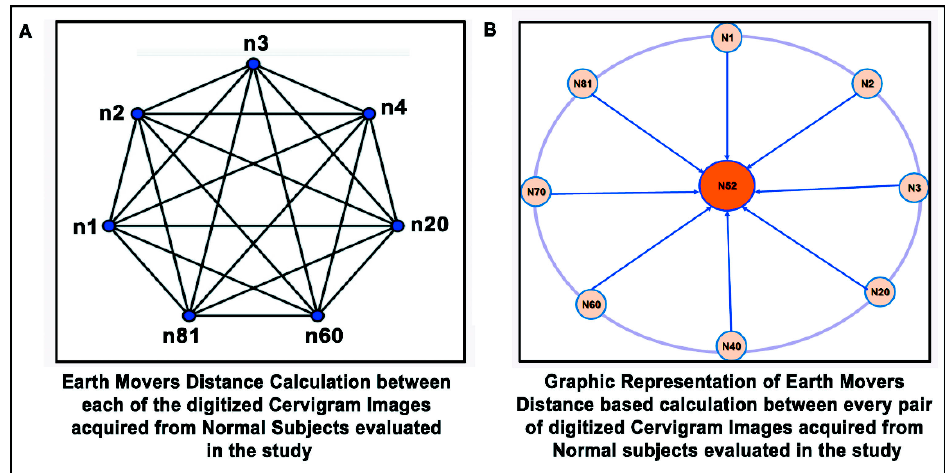
Figure 3. Earth Mover’s Distance-based calculation of distances between normal cervigrams among the subjects evaluated at Batra Hospital: in the present study, cervigrams of 81 normal subjects were acquired from the outpatient department of Batra Hospital and Medical Research Centre (BHMRC) after obtaining prior institutional ethical clearance and informed patient consent. Each of the 81 cervigrams obtained from age-matched normal subjects were compared with each other to calculate the variance between the cervigrams of the normal subjects. The Earth Mover’s Distance (EMD) enabled calculation of the variance within the cervigrams of the normal subjects and enabled the calculation of the threshold value for the cervigrams of the normal subjects, which in this case, was found to be 26.77 obtained from normal subjects evaluated from the OPD of BHMRC, New Delhi. This threshold value was used to demarcate the normalness of the cervigrams along with its comparison with the abnormal cervigrams as observed in the patients evaluated in the outpatient department of Batra Hospital and Medical Research Centre, Delhi as a part of the current study. Table 2. Range measurement of different categorical cervigrams: this table depicts the EMD value- based computational tagging of cervigrams into different categories such as normal, abnormal, cervicitis, precancerous, and precancerous/cancerous lesions. The EMD values obtained from the cervigrams form the rationale for developing OM—the OncoMeter, a scale used for computational tagging of the cervigrams in the order of their severity, thereby facilitating the triaging of lesions. Accurate Classification Tagging of Cervigrams No. of Cervigrams EMD Range on OM—The OncoMeter of Cervigrams by OM Normal 102 68 0–26.77 Abnormal (Nabothian cyst,